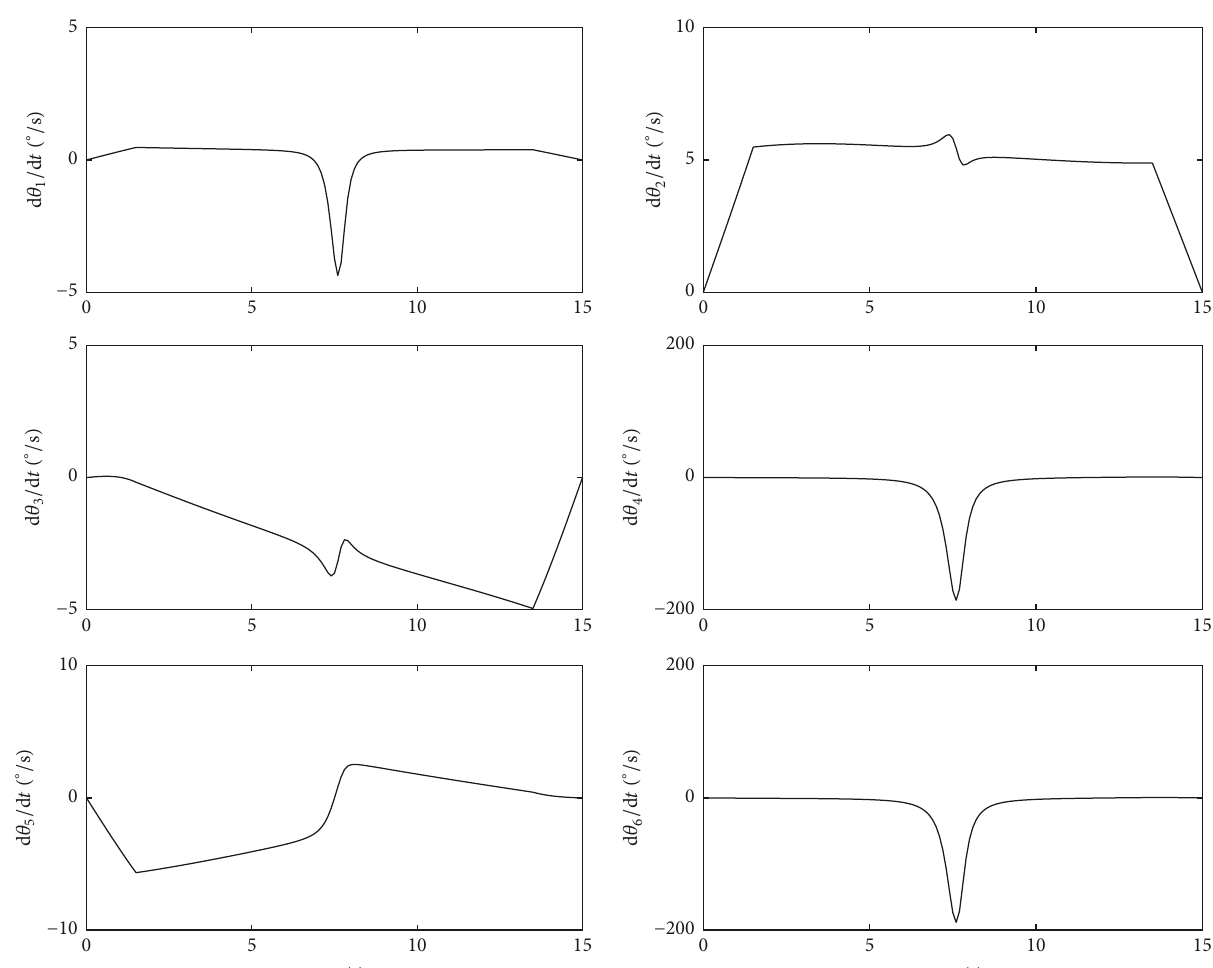
Figure 6: The joint velocity path planned by inverse